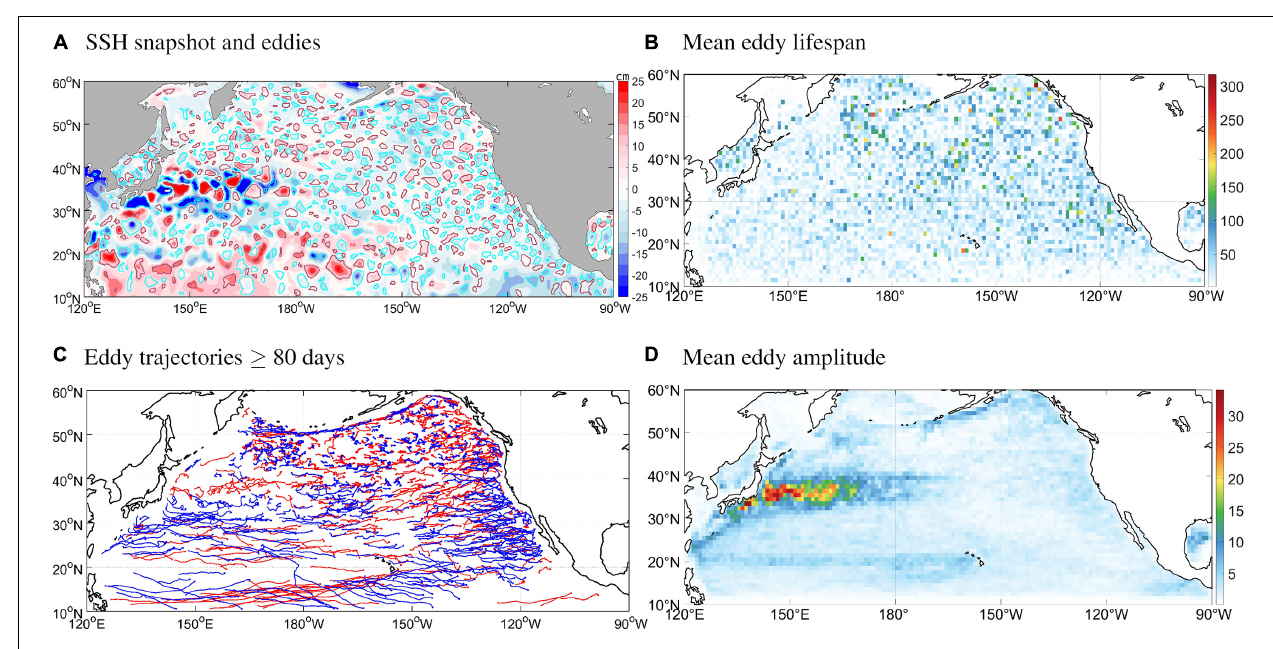
FIGURE 1 | (A) Snapshot of the SSH anomaly (cm) field on January 1, 2008 (shading). Anomaly is defined as the departure from the climatological annual cycle. Areas enclosed by the red (cyan) curve represents the identified anticyclonic (cyclonic) eddies. (B) Mean eddy lifespan (days) averaged within 1 ◦ × 1 ◦ grid cells organized by the generation location of eddies. (C) Trajectories of eddies with lifespan longer than 180 days detected on January 1, 2008. Red (blue) curves represent the trajectories of anticyclonic (cyclonic) eddies. (D) Mean eddy amplitude (i.e., SSHA, cm) averaged within 1 ◦ × 1 ◦ grid cells organized by the instantaneous location of eddies. Shown are the absolute values averaged across cyclonic and anticyclonic